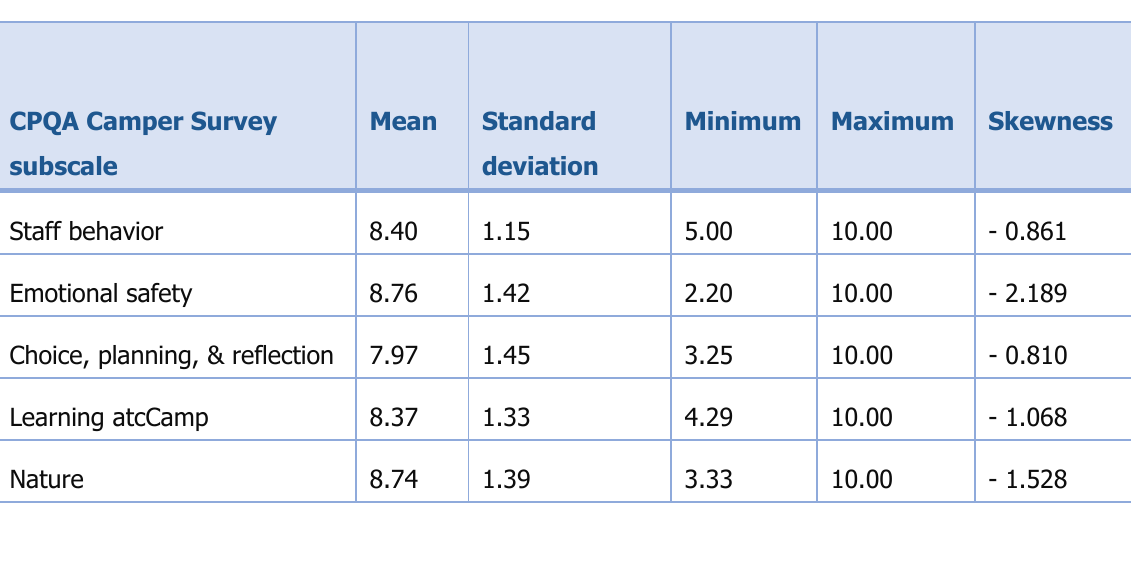
Table 1. Camper Perceptions of Program Quality Subscale Descriptive Statistics